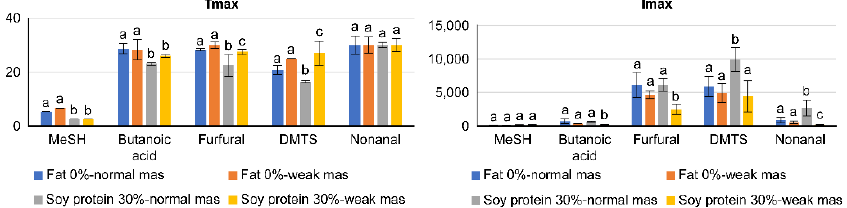
Figure 3. Changes in the release of aroma compounds due to differences in the strengths of masti- cation and in contents of soy protein (Tmax and Imax values). Statistical analyses were performed independently for each aroma compound. Different letters on top of bars mean significant differences ( α = 0.05).